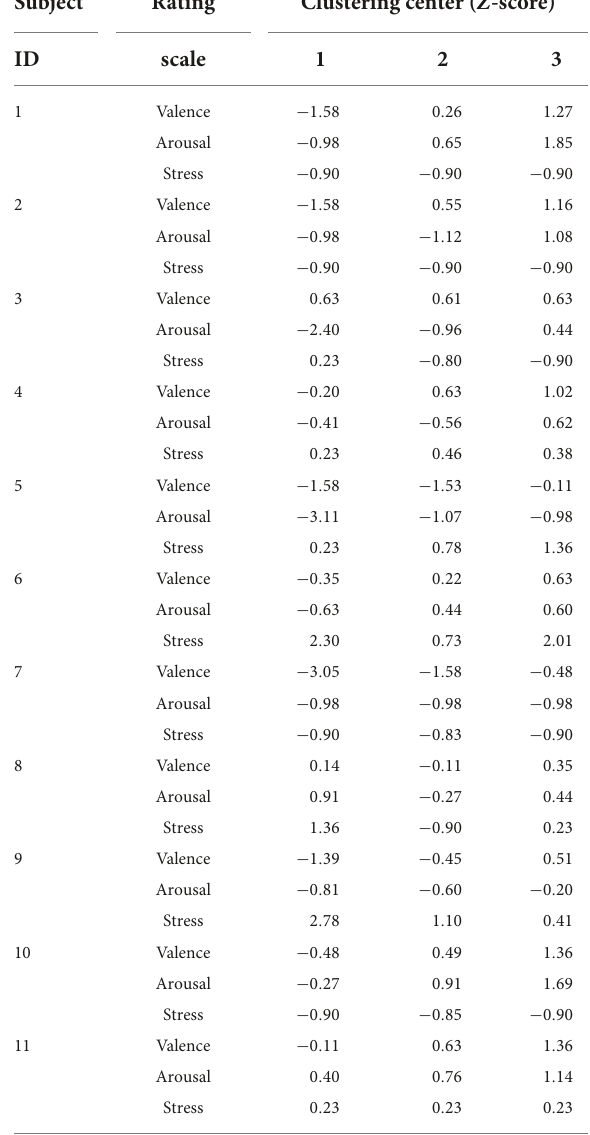
TABLE 3 Division of OCER into three motions by